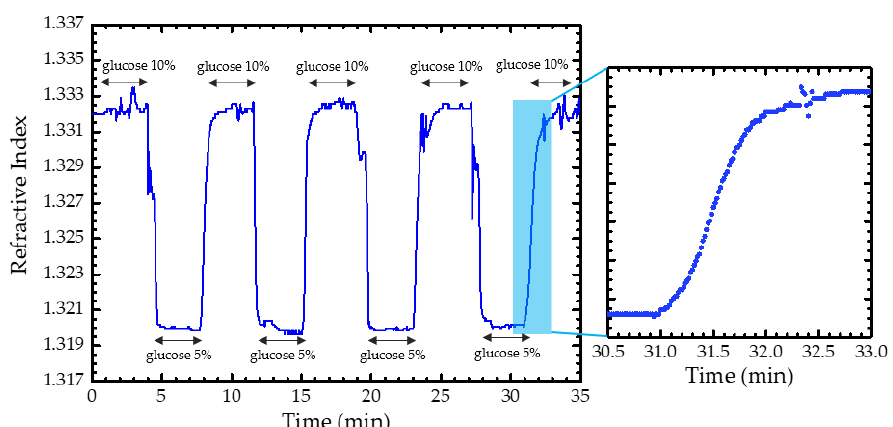
Figure 7. Optofluidic fiber sensor real-time measurement of refractive index in transitions between samples of 5 wt.% and 10 wt.% of glucose.